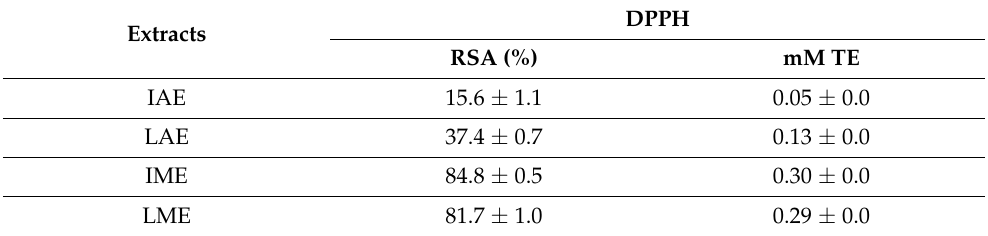
Table 8. RSA% and mM Trolox values of Chinook hops extracts in DPPH assays.